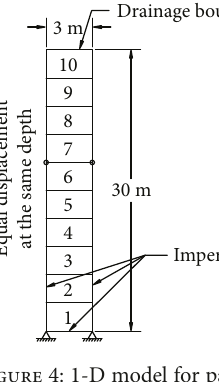
Figure 4: 1-D model for parametric study.